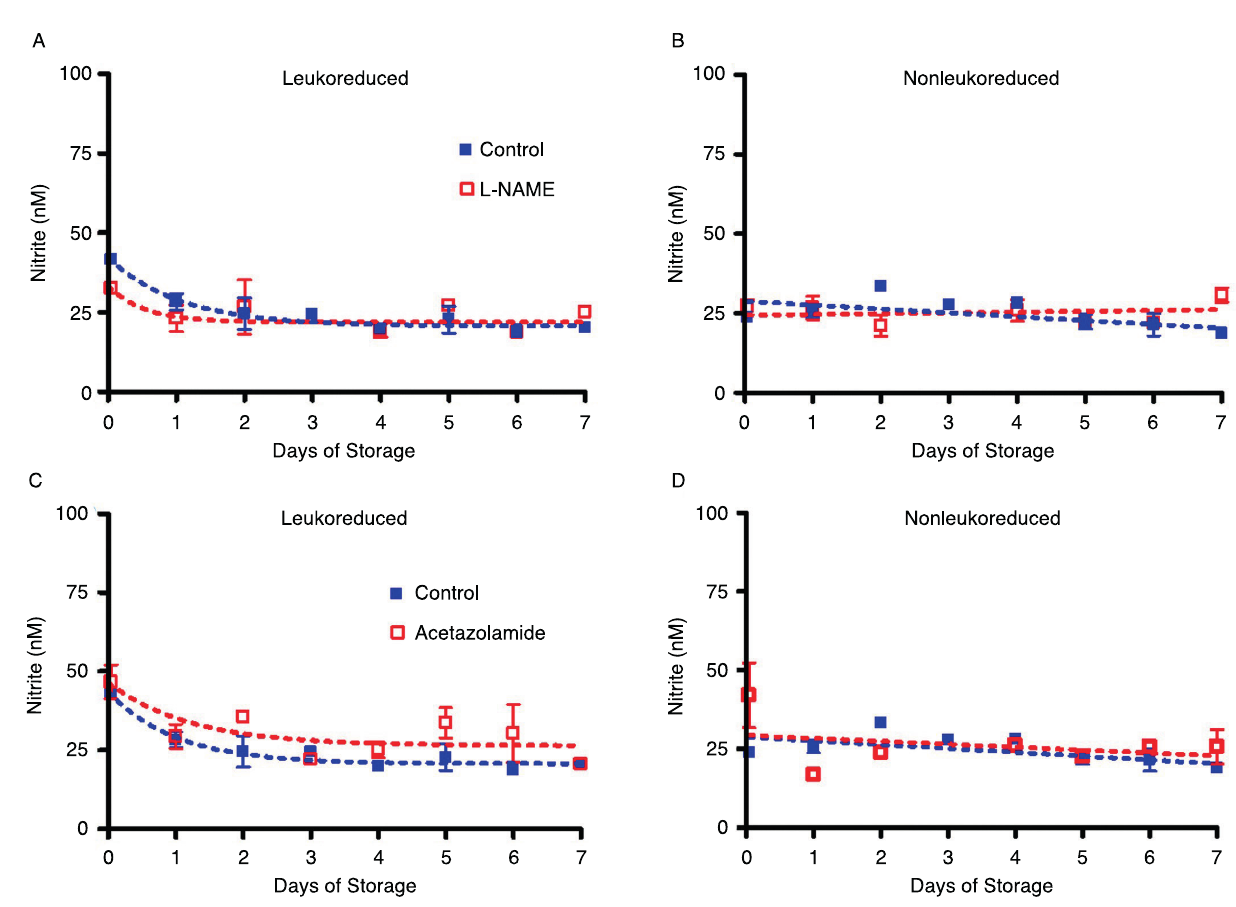
Supplemental Figure 4. Enzyme inhibition of NO production. Inhibition of NOS with L-NAME in leukoreduced RBCs (S4A) and non-leukoreduced RBCs (S4B); number of donors, n=2. S4C and S4D show inhibition of carbonic anhydrase with acetazolamide in leukoreduced RBCs and in non-leukoreduced RBCs, respectively; number of donors, n=2. All bags were stored in room air at 4°C for 7